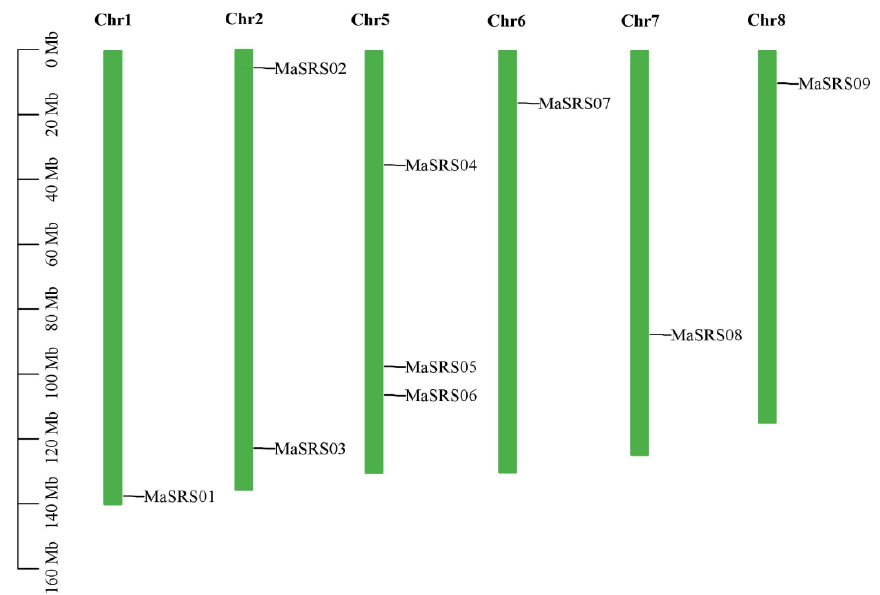
Figure 1. Chromosome distribution of MaSRS genes. Note: chromosome number is indicated at the top of each bar. Chromosomal distances are indicated in Mb.